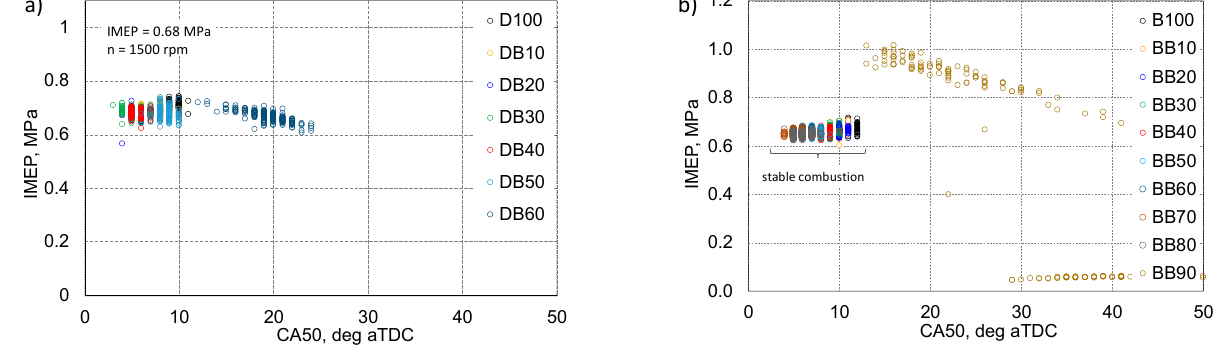
Figure 14. Interdependence of IMEP and CA50 for DB ( a ) and BB ( b ).